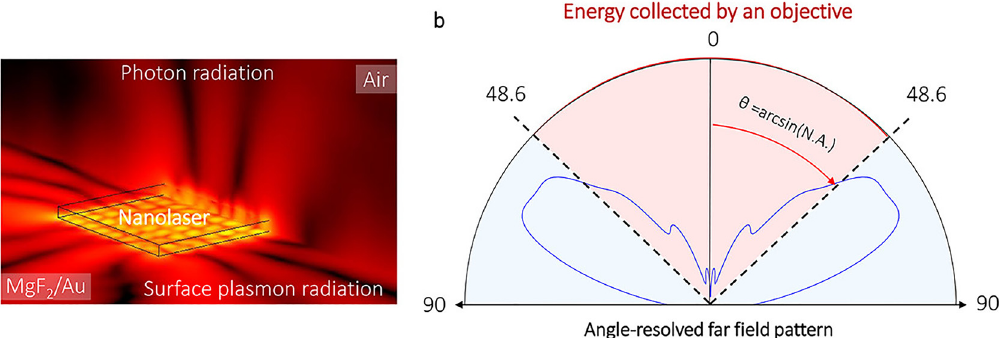
Figure 3: Quantum efficiency of plasmonic nanolasers. a Theradiation fi eldofaplasmonicnanolaserconsiststwoparts,thephotonsscatteredtotheopticalfar fi eldandthedarkemissionofsurface plasmons propagating evanescently in the near fi eld. b Full lasing properties can be reconstructed by three dimensional full wave simulation when the lasing eigenmode is identi fi ed. And thereby, full emission power can be extrapolated by only measuring a certain part of it. Figure adapted